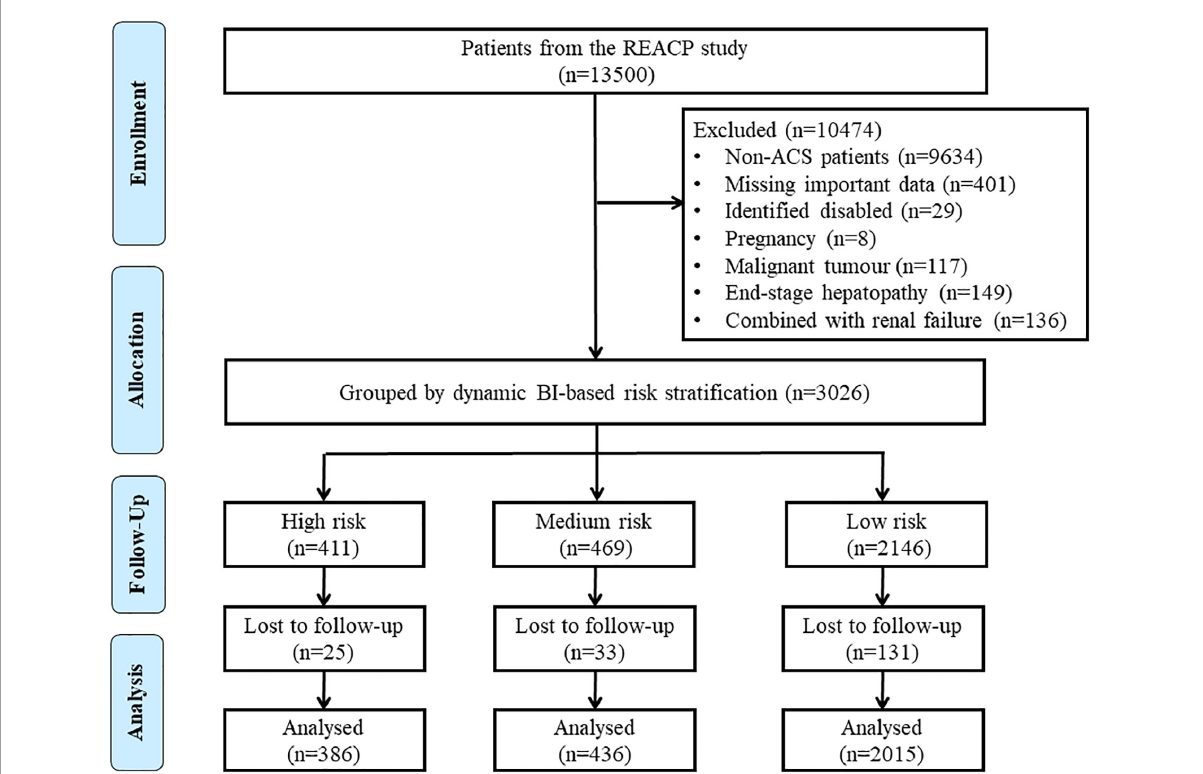
FIGURE1 Flow chart of the enrollment of participants in the study. ACS, acute coronary syndrome; BI, Barthel index; REACP, the multicentre retrospective evaluation of acute chest pain study.